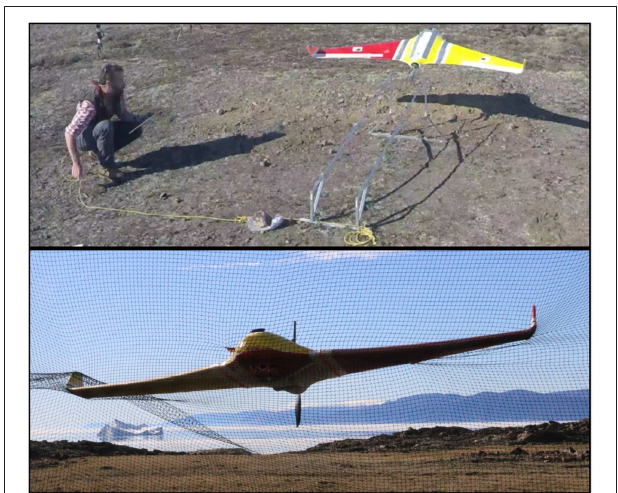
FIGURE 3 | Take-off and landing in rough terrain: the fixed-wing UAV at take-off shortly after releasing the bungee (top), and during landing into the net